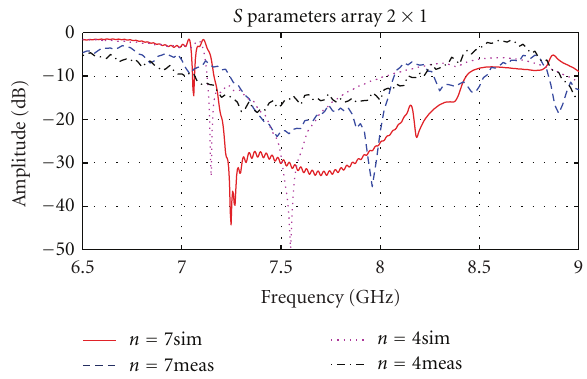
Figure 12: Transmission parameters ( S 21 ) for F shape mushrooms.